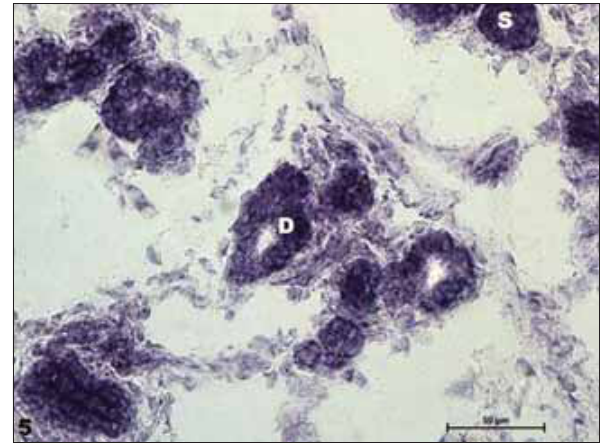
Figure-5: Photomicrograph of 54 cm curved crown- rump length (195 days) buffalo fetus showing moderate to strong nicotinamide adenine dinucleotide diaphorase activity in serous acini (S) and ductular epithelium (D) of submandibular salivary gland (Nitro BT method × 400).